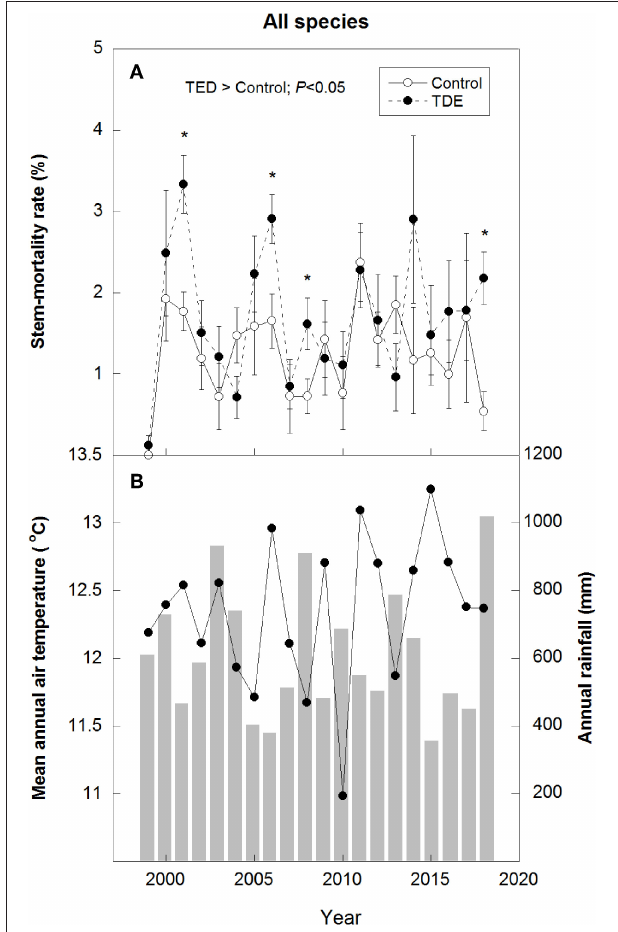
FIGURE 6 | Annual stem-mortality rates in the control and TDE plots for all species studied (A) and annual meteorological data (mean air temperatures and total rainfall) (B) . Black dots represent temperature values, and gray bars represent rainfall values. Error bars correspond to the standard error of the mean ( n = 4). * P <